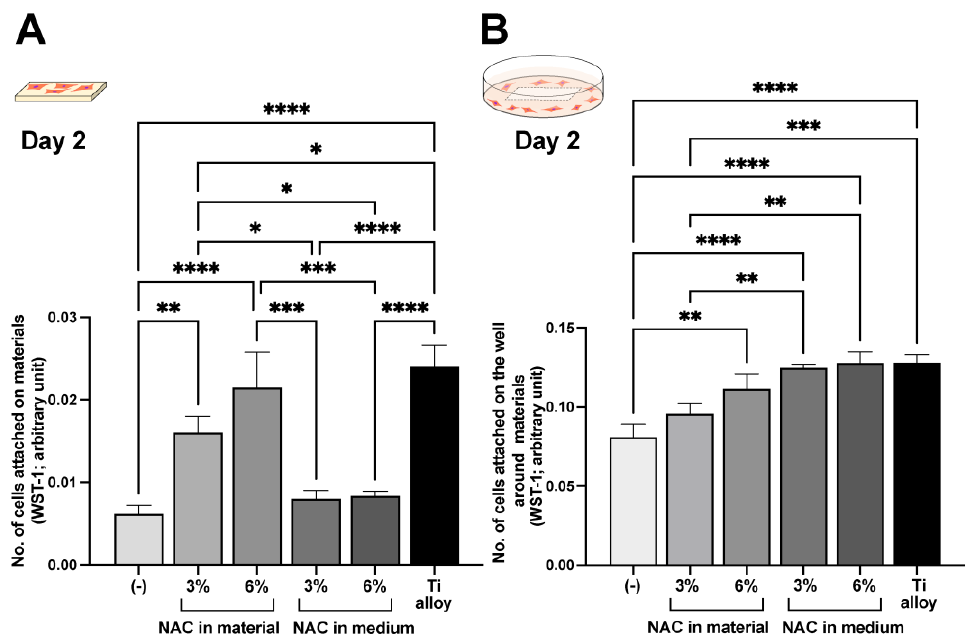
Figure 7. Effects of NAC administration methods. NAC was administered by material impregnation or by supplementing in the culture medium. The WST-1 assay was conducted on culture day two to quantify the number of cells attached to each material ( A ) and to the culture well around each material ( B ). Note that the same amount of NAC was added between the impregnation and supplementation methods. See the Materials and Methods sections for details: * p < 0.05, ** p < 0.01, *** p < 0.001, and **** p < 0.0001.